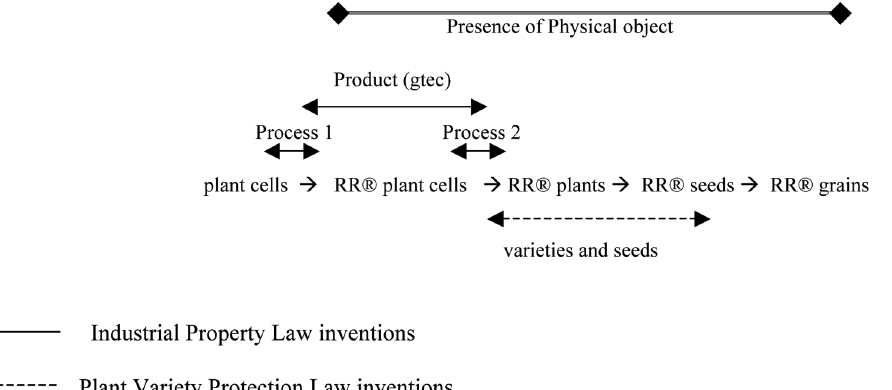
Fig. 2 – In the scheme above, the solid line corresponds to a subject matter regulated by the Industrial Property Law. The process claim 1 is the process to produce a genetically modified cell, and the process claim 2 is the process to produce a genetically modified plant. The product (physical object) refers to the glyphosate tolerance expression cassette (genetic product or gtec) inserted in the plant genome. Although this product is alongside of the grain chain (see double line), the exhaustion of rights of this product’s claim occurred at the moment of its legal use to develop a genetically modified plant. The dotted line corresponds to the protection by the Plant Variety Protection Law, which protects the plant variety and the reproduction or vegetative multiplication parts of RR ® seeds. The grains are seeds that are consumed and, therefore, they should not be legally considered as reproductive or multiplicative materials by the Plant Variety Protection